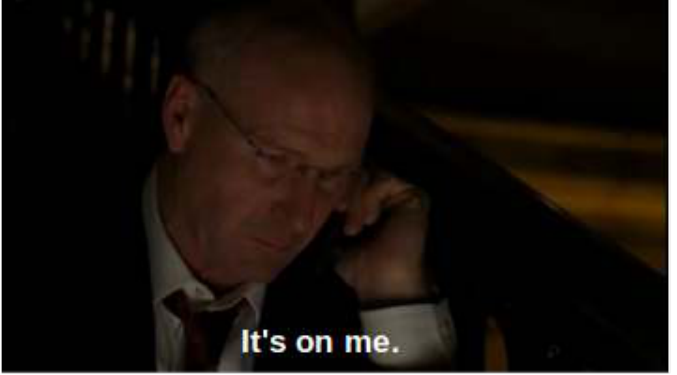
Figure 3: A decent man dedicated to his country: Henry Paulson (William Hurt) in Too Big To Fail , by Curtis Hanson.